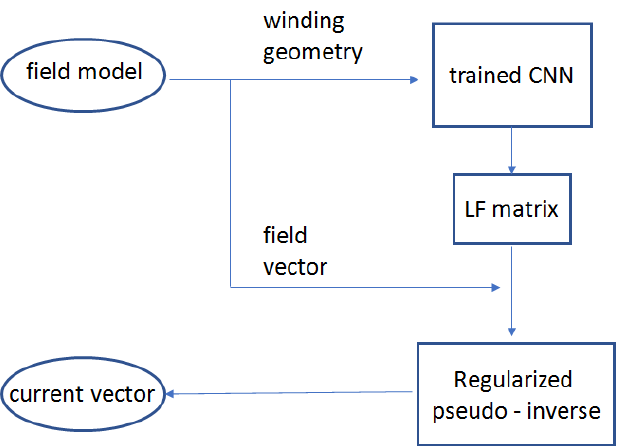
Figure 2. Block diagram of the method based on Neural Networks and Deep Learning.